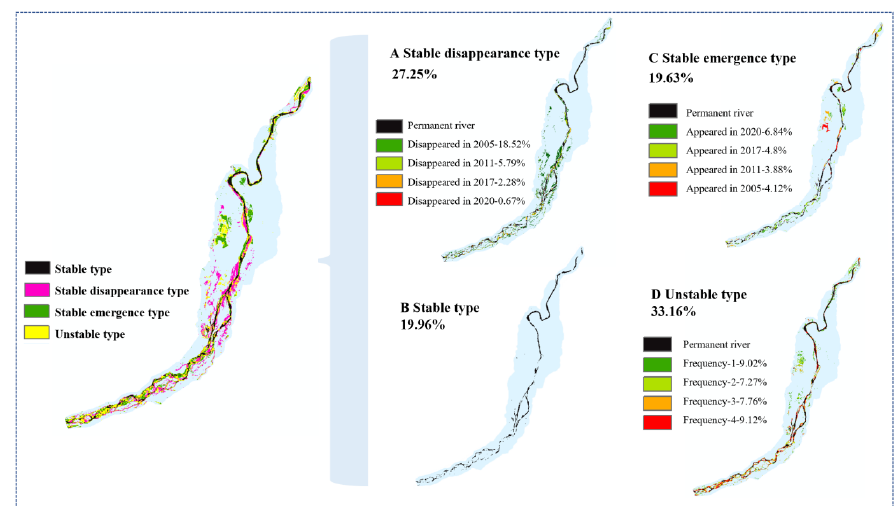
Figure 5. Spatial and temporal map of water distribution.